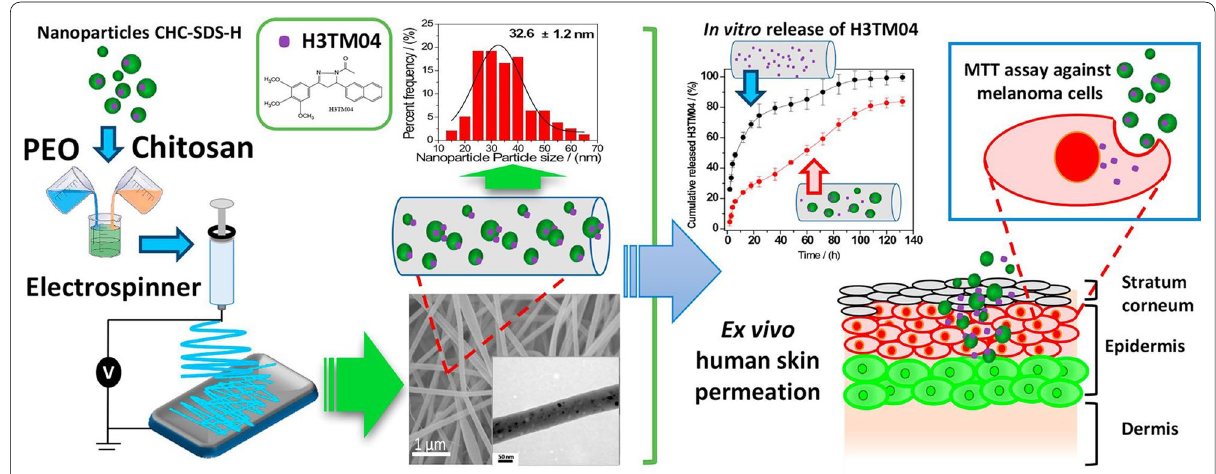
Fig. 5 PEO-Chitosan Nanofibers employed for the management of skin cancer. Reproduced with permission from Rengifo et al.